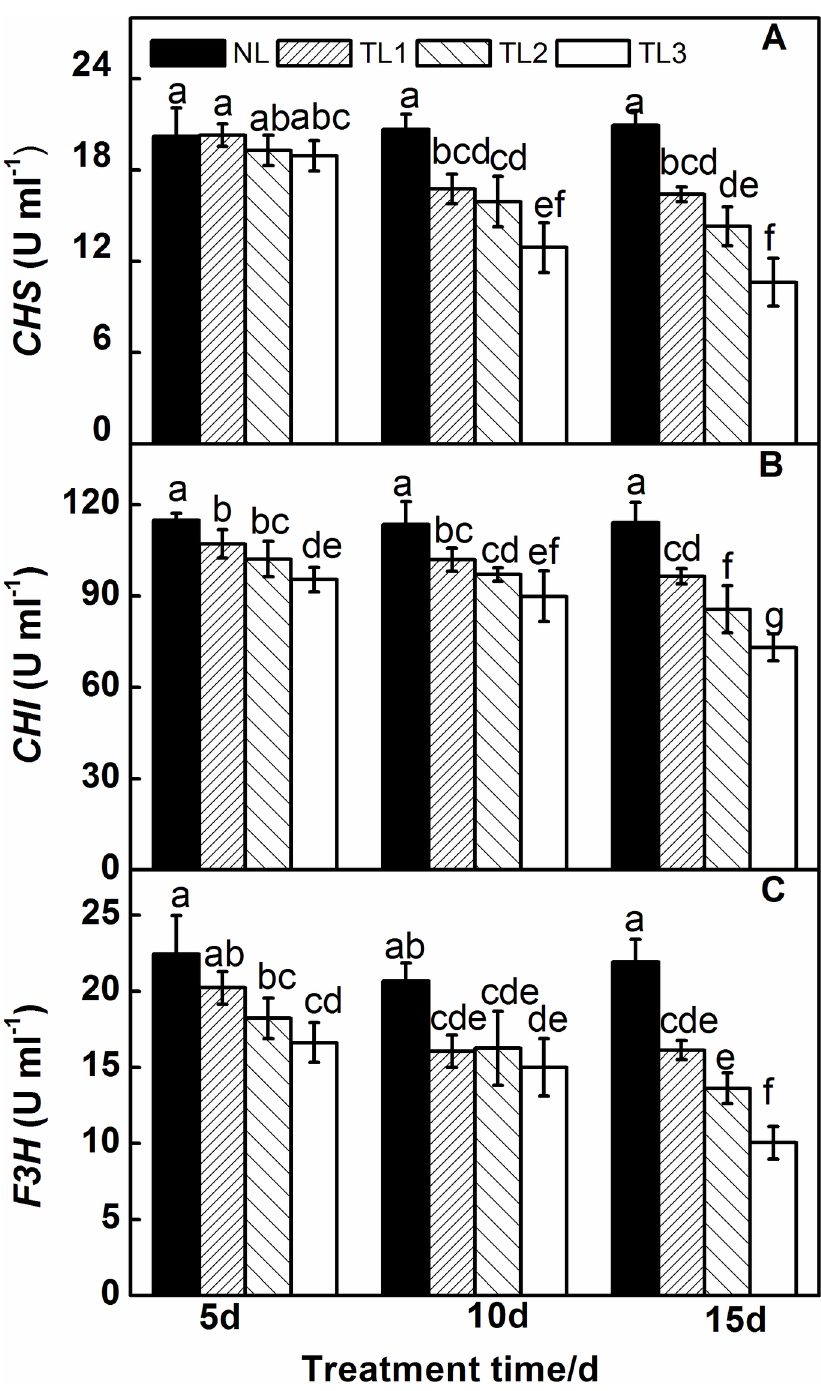
Fig 6. Effects of low light on chalcone synthase ( CHS ), chalcone-flavanone isomerase( CHI ), flavanone-3- hydroxylase hydroxylation ( F3H ), activities in the leaves of purple pak-choi seedlings. The data are the means of three replicates, with SDs shown as vertical bars . The means marked with different letters indicate significantdifference betweentreatments at p < 0.05,as determinedwith Duncan’smultiple range test. Different lower-caseletters at each time point indicate significantdifferences betweentreatments.